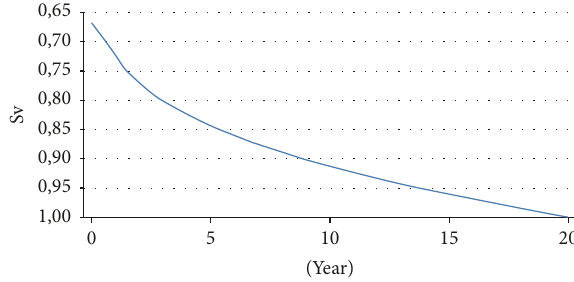
Figure 4: Increase of capacity utilization coefficient Sv.